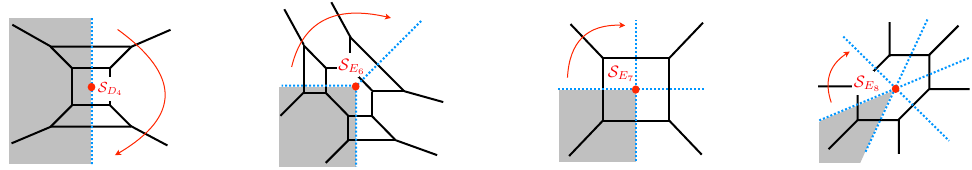
Figure 9 . The Z 2 , Z 3 , Z 4 , Z 6 S-folding prescriptions (from left to right). We choose the gray region as the fundamental domain of ( p, q ) -plane after the Z with a subscript denoting the global symmetry assigned at the